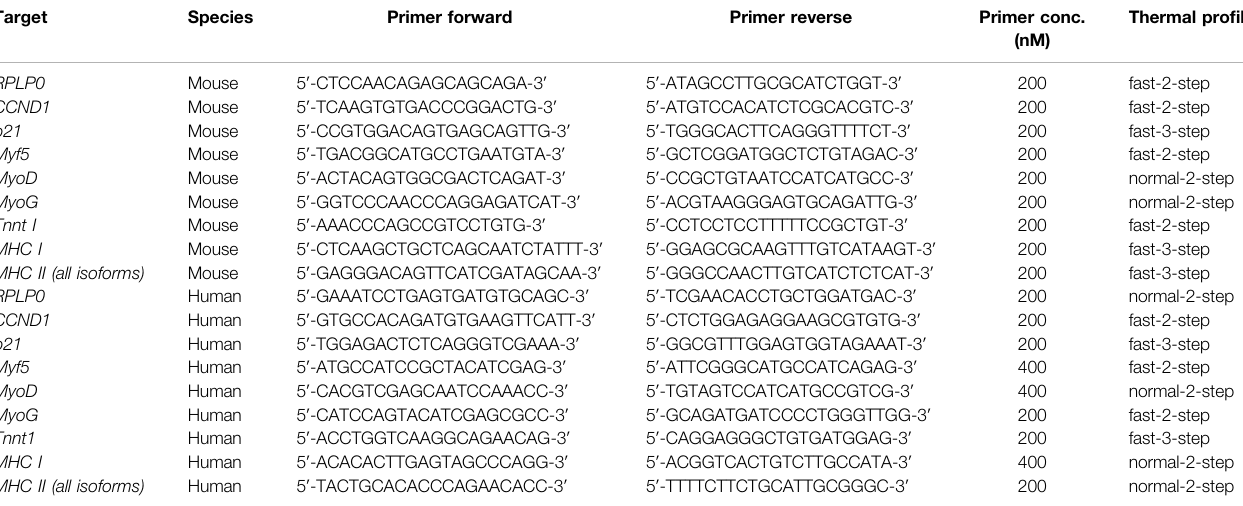
TABLE 2 | Primer sequences, primer concentrations and thermal pro fi les used for qPCR.